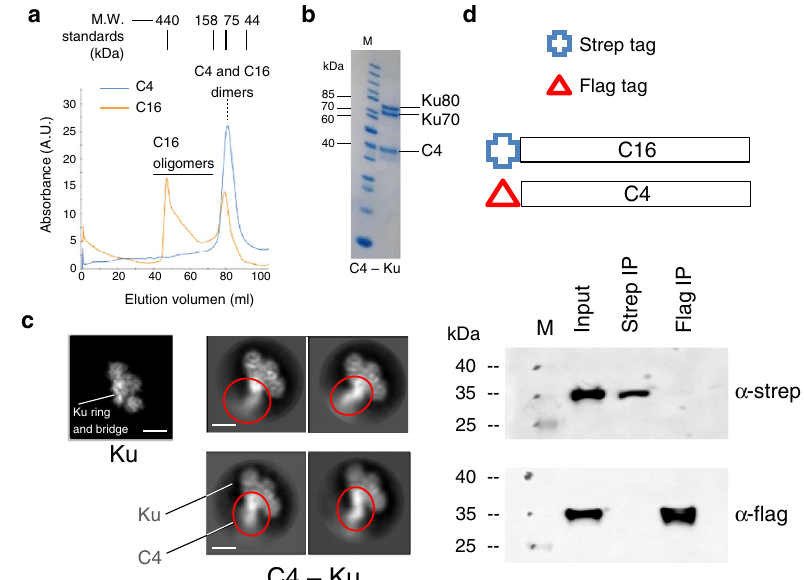
Fig.6|Puri fi cationandcryoEMoftheC4 – Kucomplex.a SECofC4andC16using a Superdex 200 16/600. To calibrate the column, we injected several proteins of knownmolecularweight,andtheirpositionisindicated:Ferritin(440kDa)at44ml, Aldolase (158kDa) at 73ml,Conalbumin(75kDa) at80ml and Albumin(44kDa)at 91ml. b ThepeakfractionofaSECofthemixtureofKuandC4wasanalysedbySDS- PAGEtocon fi rmtheternarycomplexformation.Molecularmarkers(M)areshown intheleft.Theexperimentshowninaandbwasrepeatedtwicewithsimilarresults. c Representative 2D averages of the cryoEM images obtained for C4 – Ku (right panels)thatcanbecomparedwiththecomputationalprojectionofthestructureof Ku(leftpanel).C4attachedtotheregionoftheringinKu,asC16,butC4appearsto